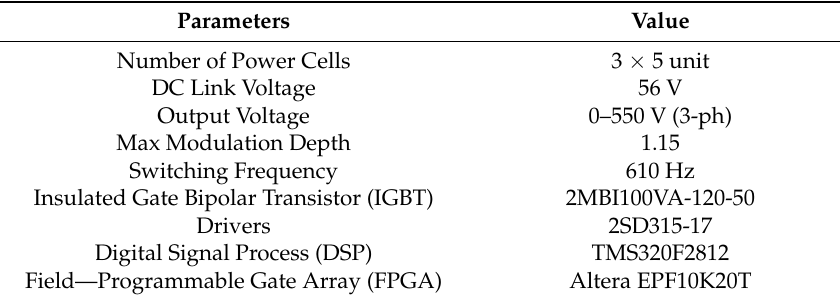
Table 2. Parameters for Experiment.